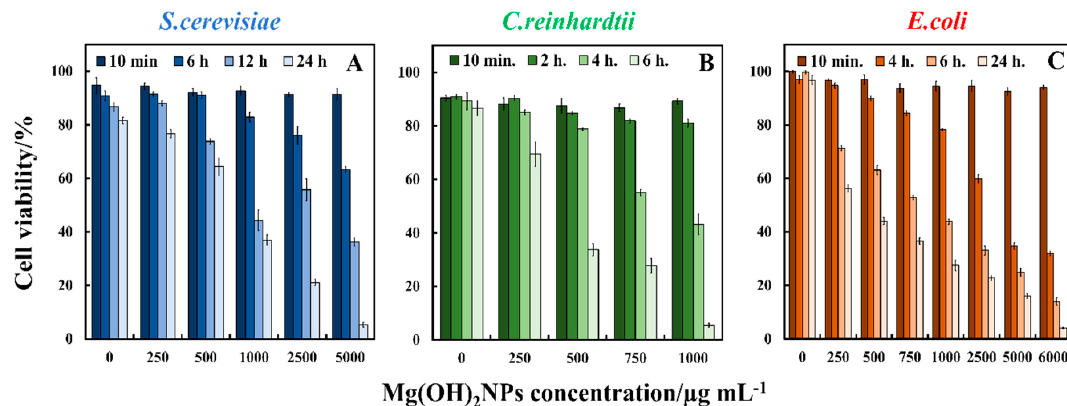
Figure 4. The antimicrobial activity of bare Mg(OH) 2 NPs on ( A ) S.cerevisiae ( B ) C. reinhardtii and ( C ) E. coli at various particle concentrations. The cells were incubated with the Mg(OH) 2 NPs at different periods of time shown.